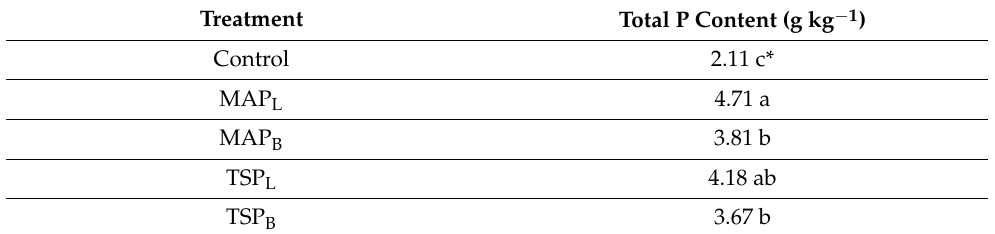
Table 3. Total P content determined at the end of the cropping period (25 days).